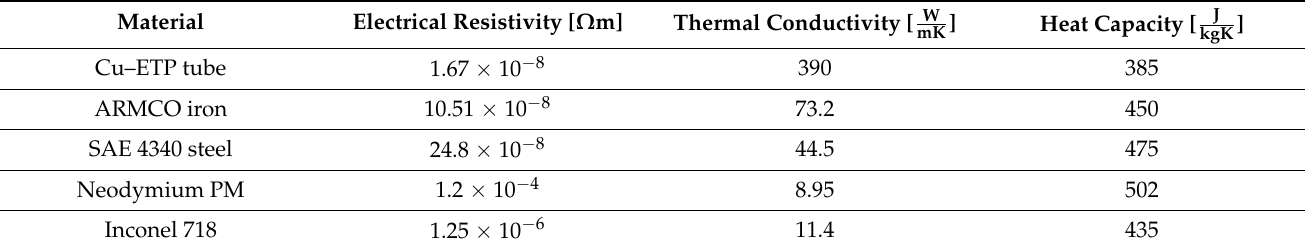
Table 2. EC damper material